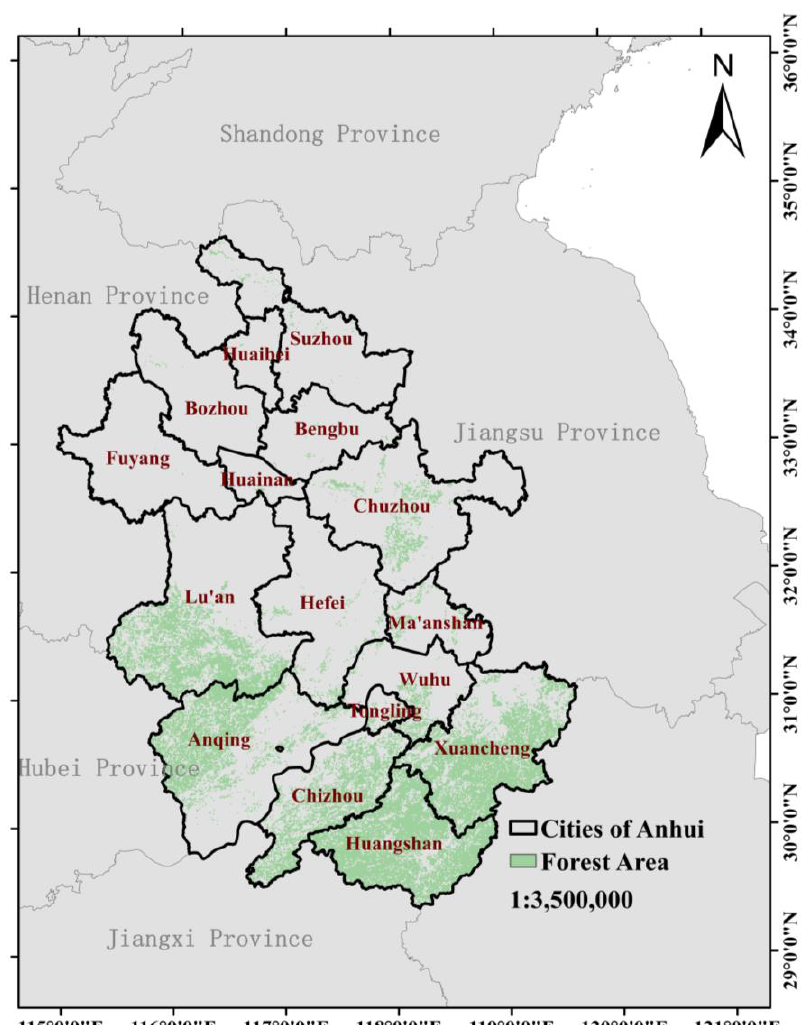
Figure 1. Location of the study area (Anhui province).